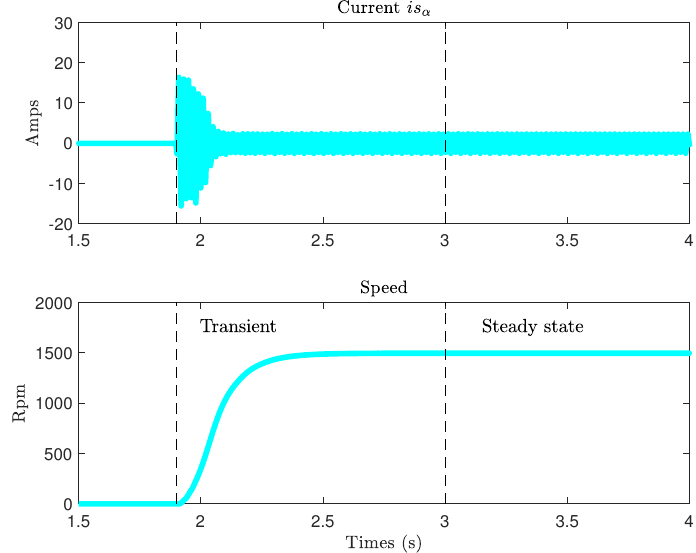
Figure 4. Direct Concordia current i s α ( t ) and